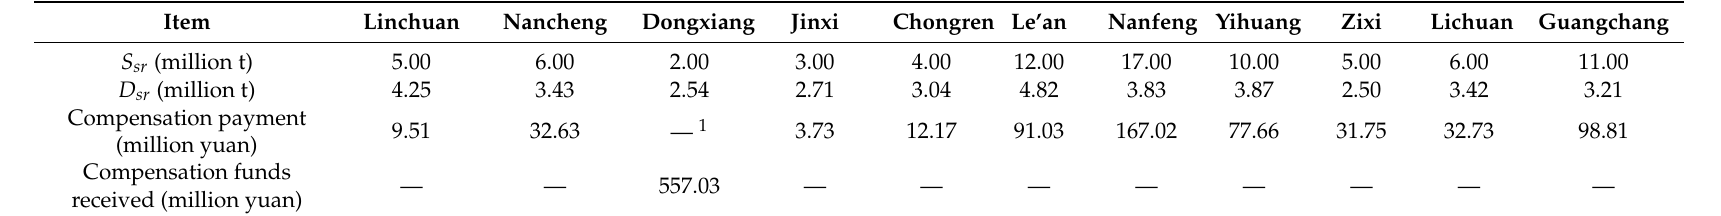
Table 4. Assessment of supply and demand for soil retention and the distribution of compensation funds.